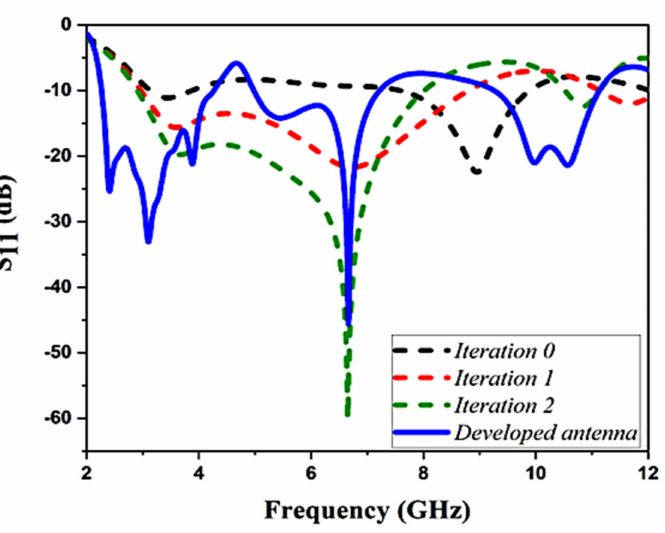
Figure 3. Simulated reflection coefficient S 11 of the various stages of the developed antenna’s design